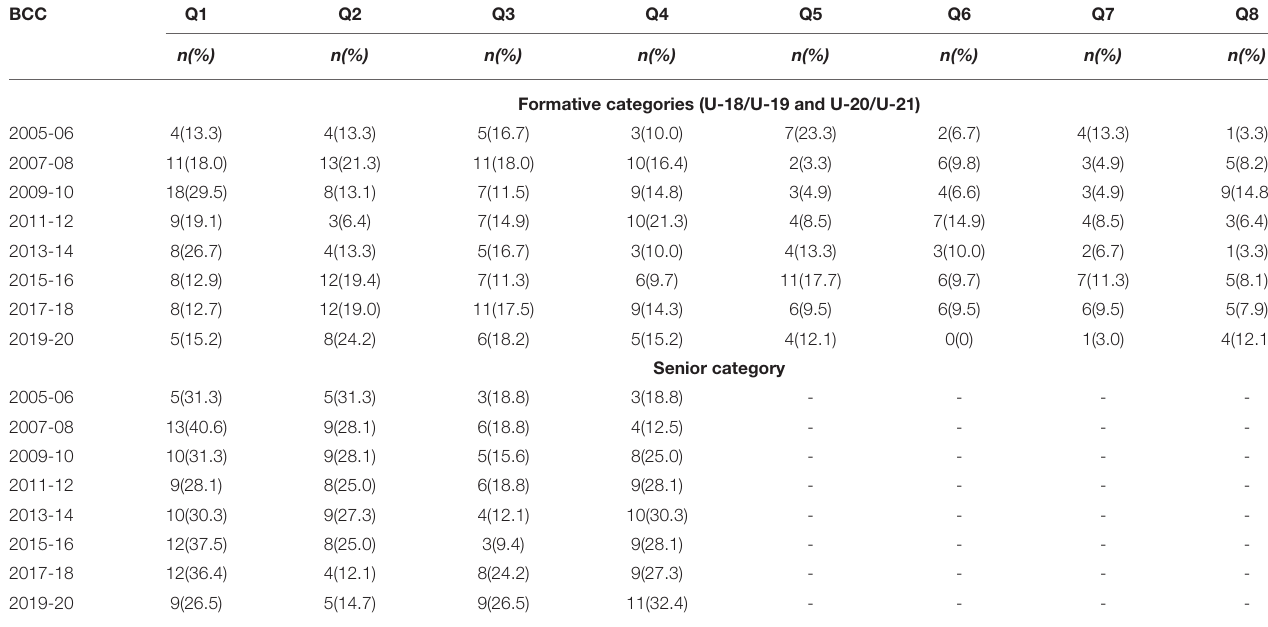
TABLE 1 | Quarterly distribution (“ n ” and “ % ”) of birthdates by competition level and biannual competition cycle. BCC Q1 Q2 Q3